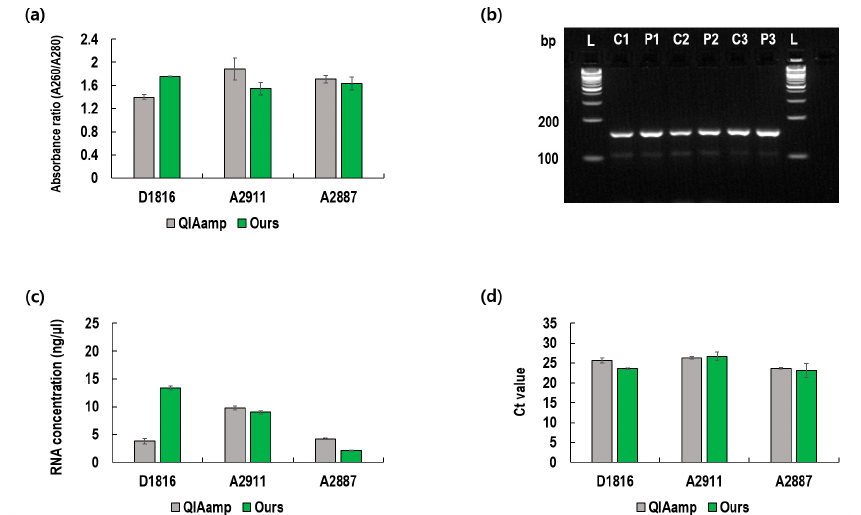
Figure 5. Comparison of the proposed method with the QIAamp kit using clinical samples. ( a ) Ab- sorbance ratio as an index of purity; ( b ) Gel electrophoresis of amplified RNA (L: DNA ladder, C1: D1816 QIAamp, P1: D1816 Ours, C2: A2911 QIAamp, P2: A2911 Ours, C3: A2887 QIAamp, P3: A2887 Ours); ( c ) Extracted RNA concentrations; ( d ) Threshold cycles of PCR amplification of extracted RNA.